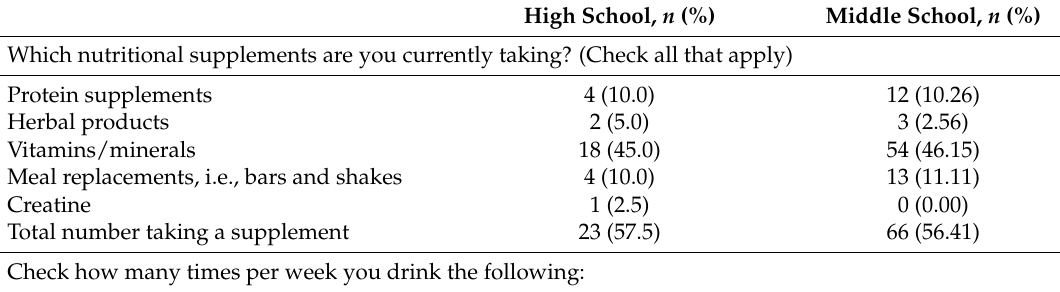
Table 6. Supplement and caffeine